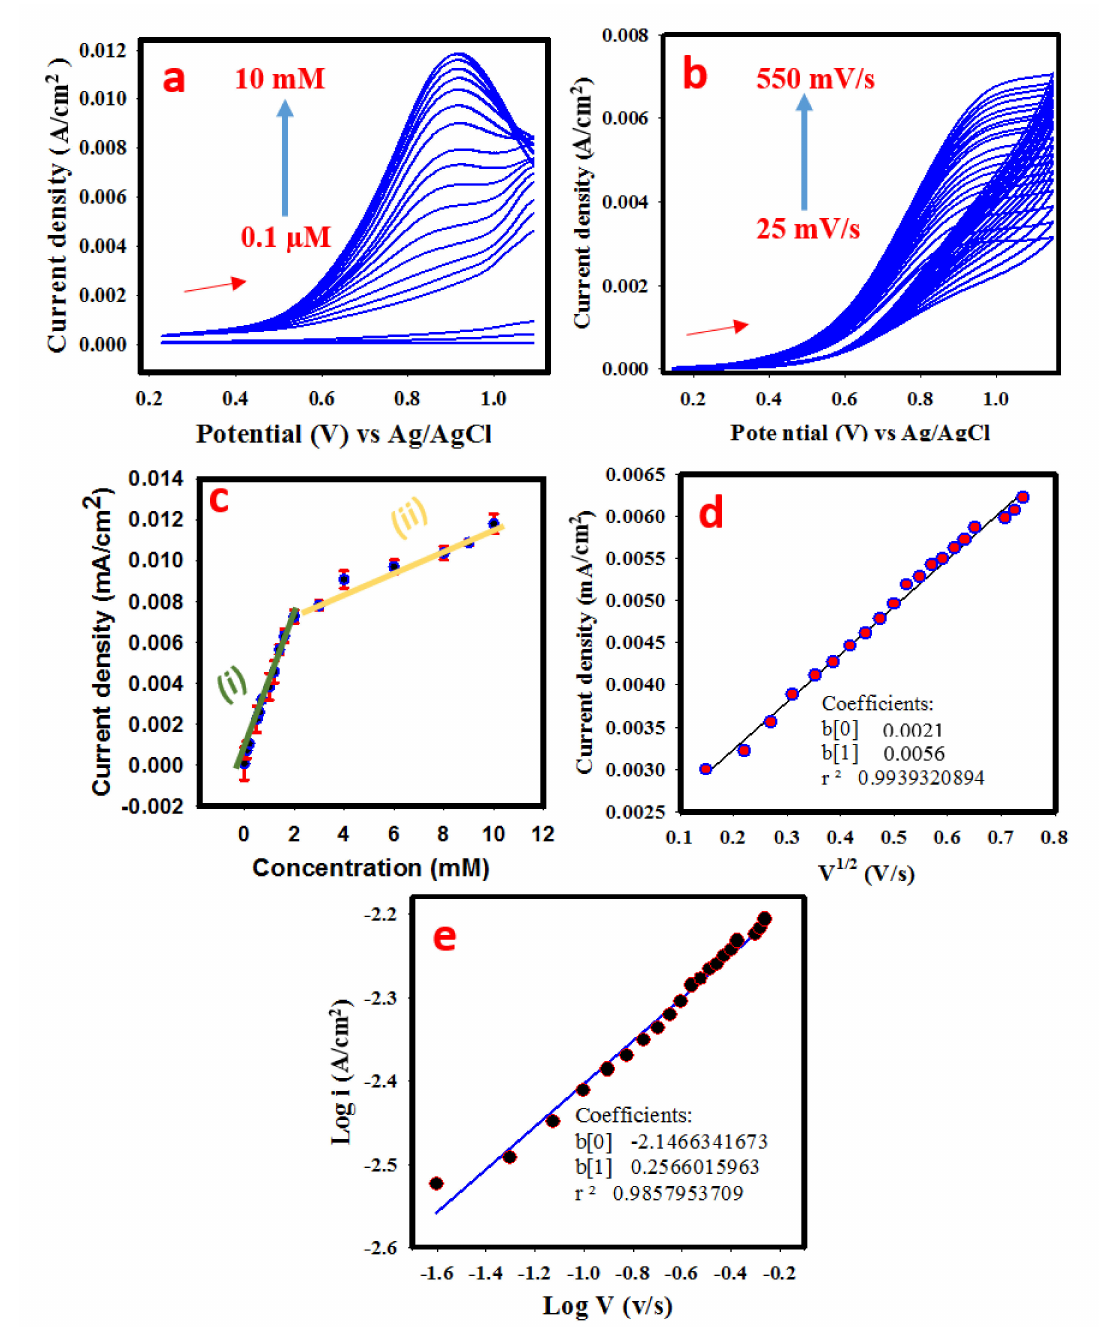
Figure 6. ( a ) Linear sweep voltammogram obtained at different glucose concentrations at the scan rate of 75 mV/s. ( b ) Cyclic voltammogram obtained in 2 mM glucose/0.1 M NaOH solution at the scan rate of 25 mV/s to 550 mV/s. ( c ) calibration plot with error bars. ( d ) Linear regression graph of oxidation current density against the square root of the scan rate. ( e ) Plot of the logarithm of oxidation current density against the logarithm of the scan